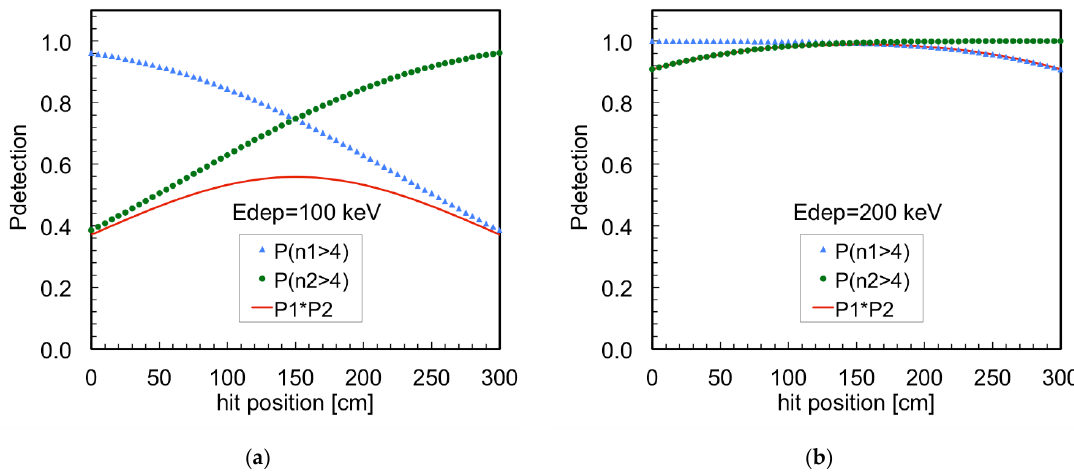
Figure 7. Detection efficiency of a gamma-ray as a function of the impact position on a 300 cm long fiber, calculated as the product of the probabilities of getting at least four photons detected on each SiPM. ( a ) When the gamma-ray deposits 100 keV . ( b ) When the gamma-ray deposits 200 keV.